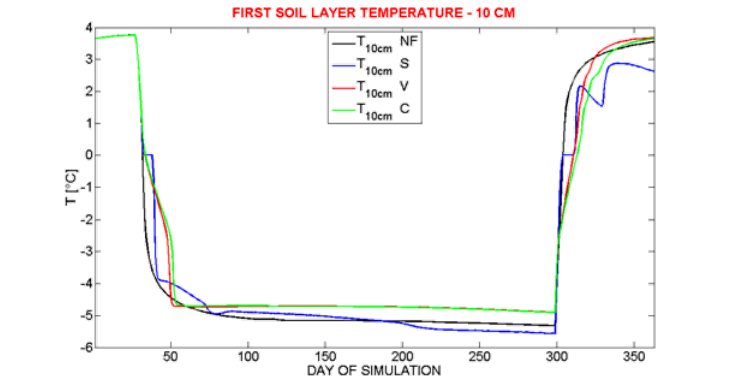
Figure 7. Soil moisture in the 10 cm soil layer (as for Figure 5) for the